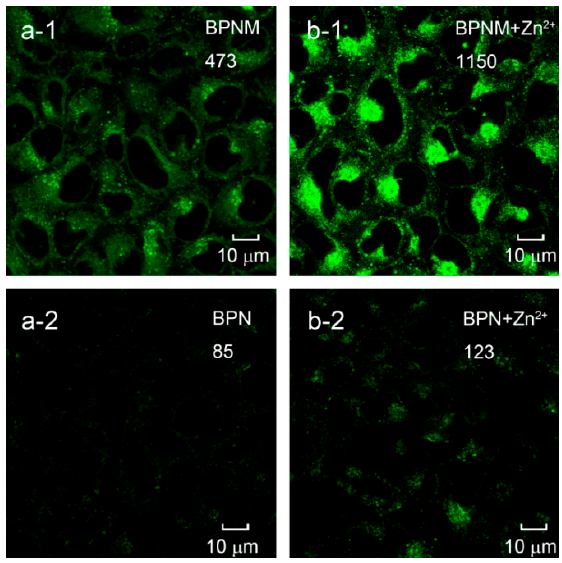
Figure 5. Two-photon confocal fluorescence images and average fluorescence intensity of MCF-7 cells stained with probe (1) BPNM and (2) BPN. Before imaging, ( a ) cells and BPNM (or BPN) (50 μ M), ( b ) cells, BPNM (or BPN) (50 μ M), and Zn 2+ (50 μ M) were co-incubated in culture medium.